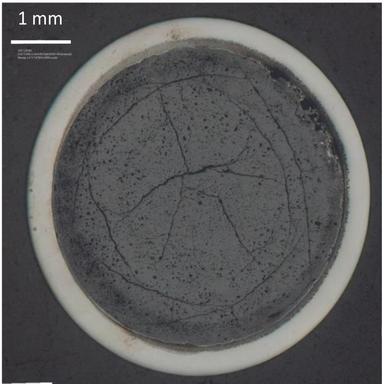
Optical image montage (50X) of the fuel cross section.